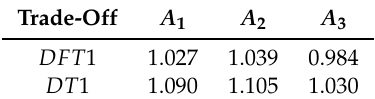
Table 9. Results by fuzzy trade-off.